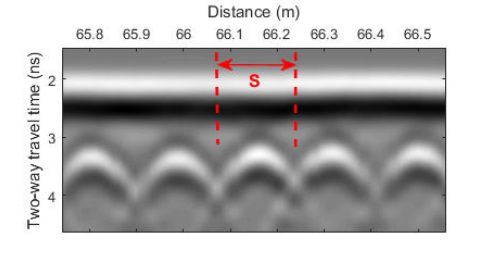
Figure 5. Averaged direct coupling amplitude along the distance "S" (half of rebars spacing from each side of the rebar) was used to normalize the rebar amplitude.